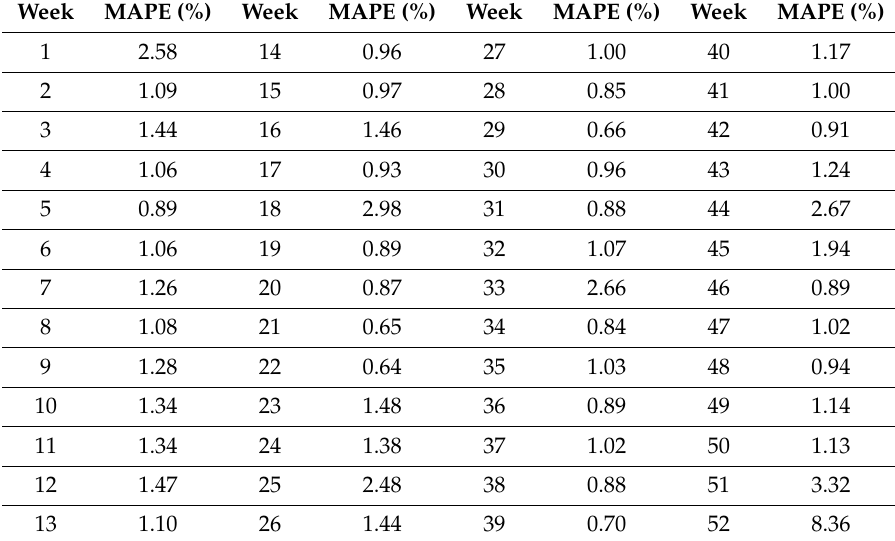
Table 8. Mean MAPE errors for every week of 2019, using an ensemble of neural networks at the application of m =